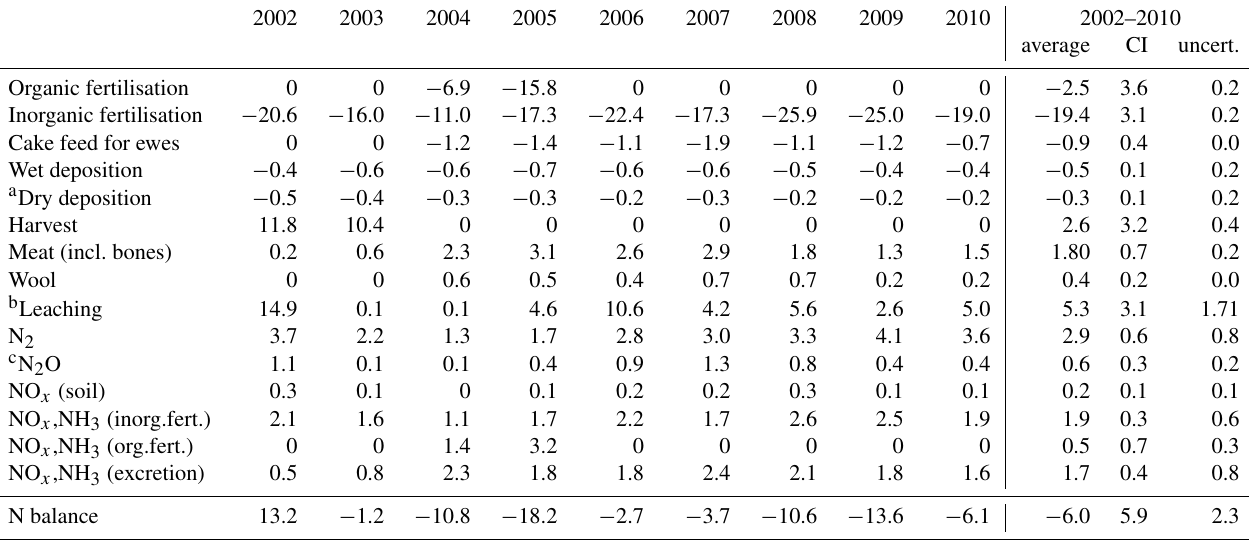
Table 3. Nitrogen budget and balance for each measurement year and average values, confidence intervals at p >0.95 (CI) and systematic uncertainties (uncert.) for 2002–2010 (gNm − 2 a − 1 ). Negative numbers represent uptake, while positive numbers represent loss of N from this grassland ecosystem. Letters indicate data published in previous